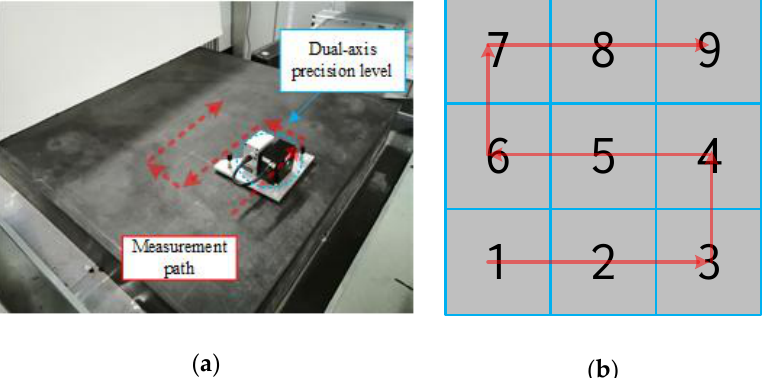
Figure 8. Measurement repeatability test: ( a ) photo of the experiment set-up; ( b ) measured positions.